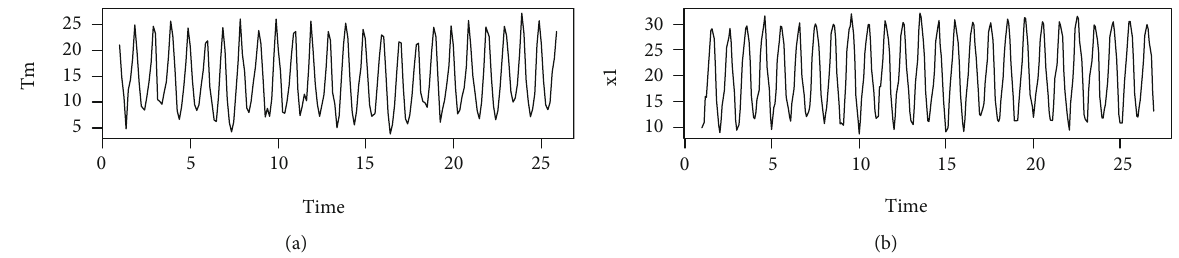
Figure 1: Plots of the monthly temperature averages series: (a) Nineveh City in Iraq for the period 1976 to 2000; (b) Tunisia (TSN) for the period 1991 to 2015.